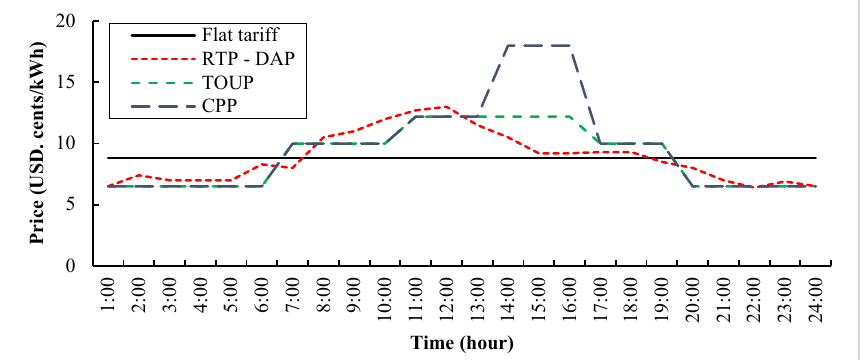
Figure 2. Price variation according to tariff scheme [4].